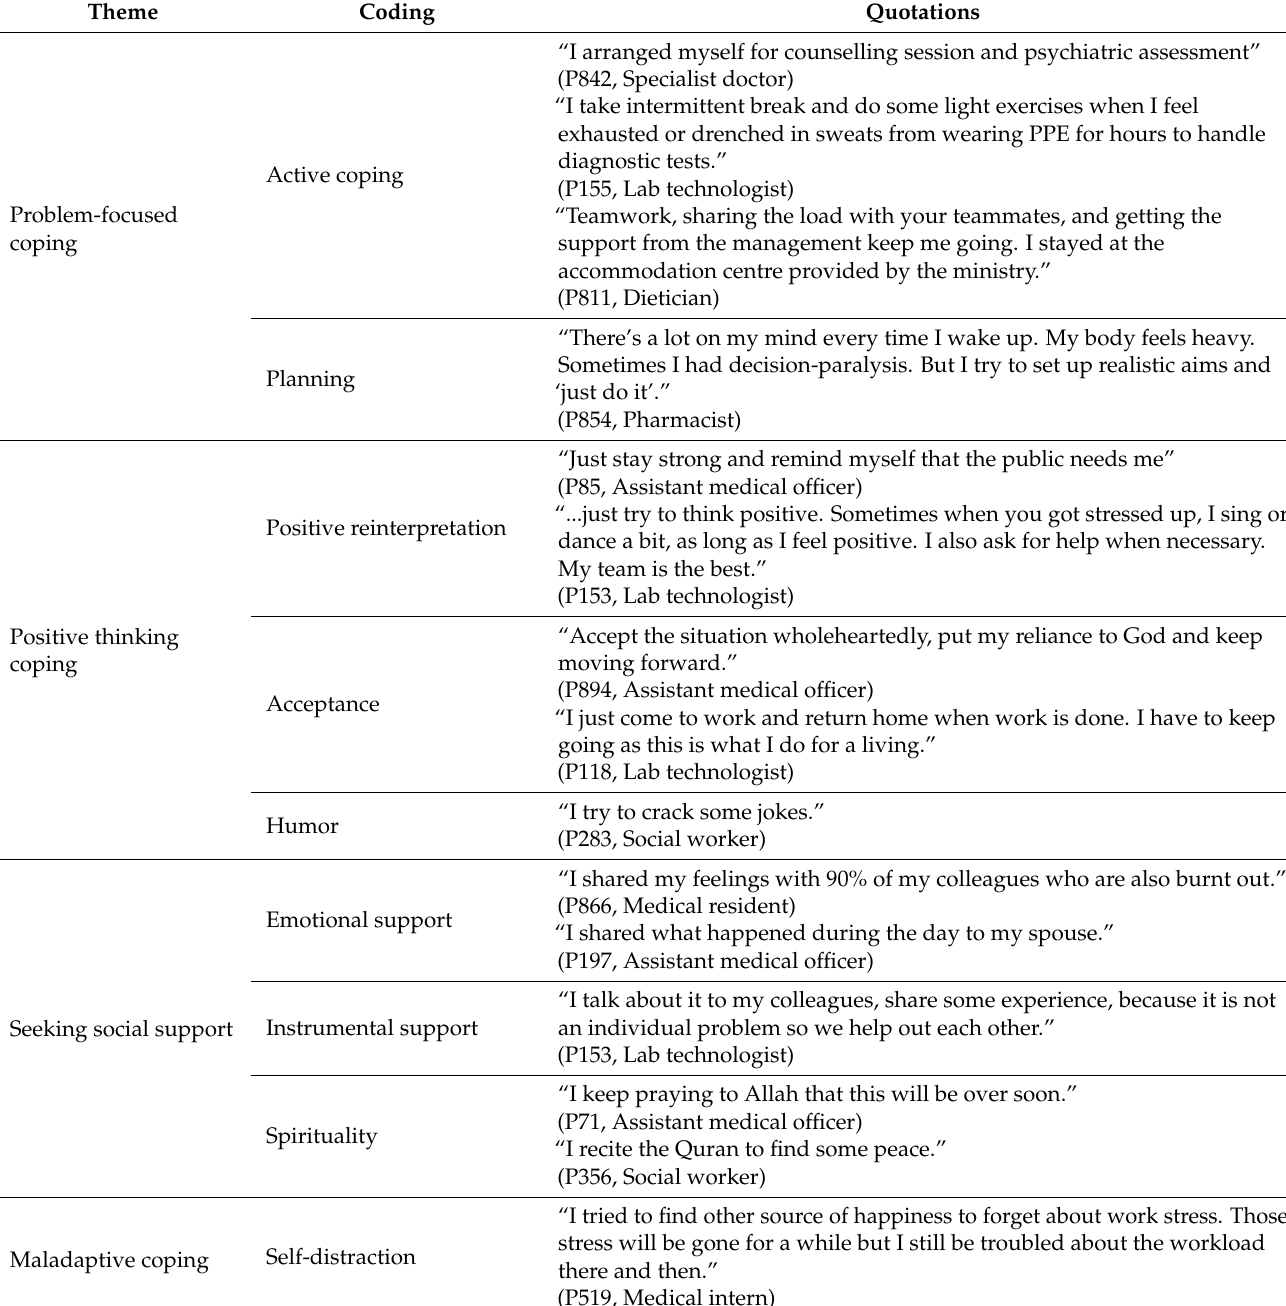
Table 7. Common self-reported coping strategies among burnt-out